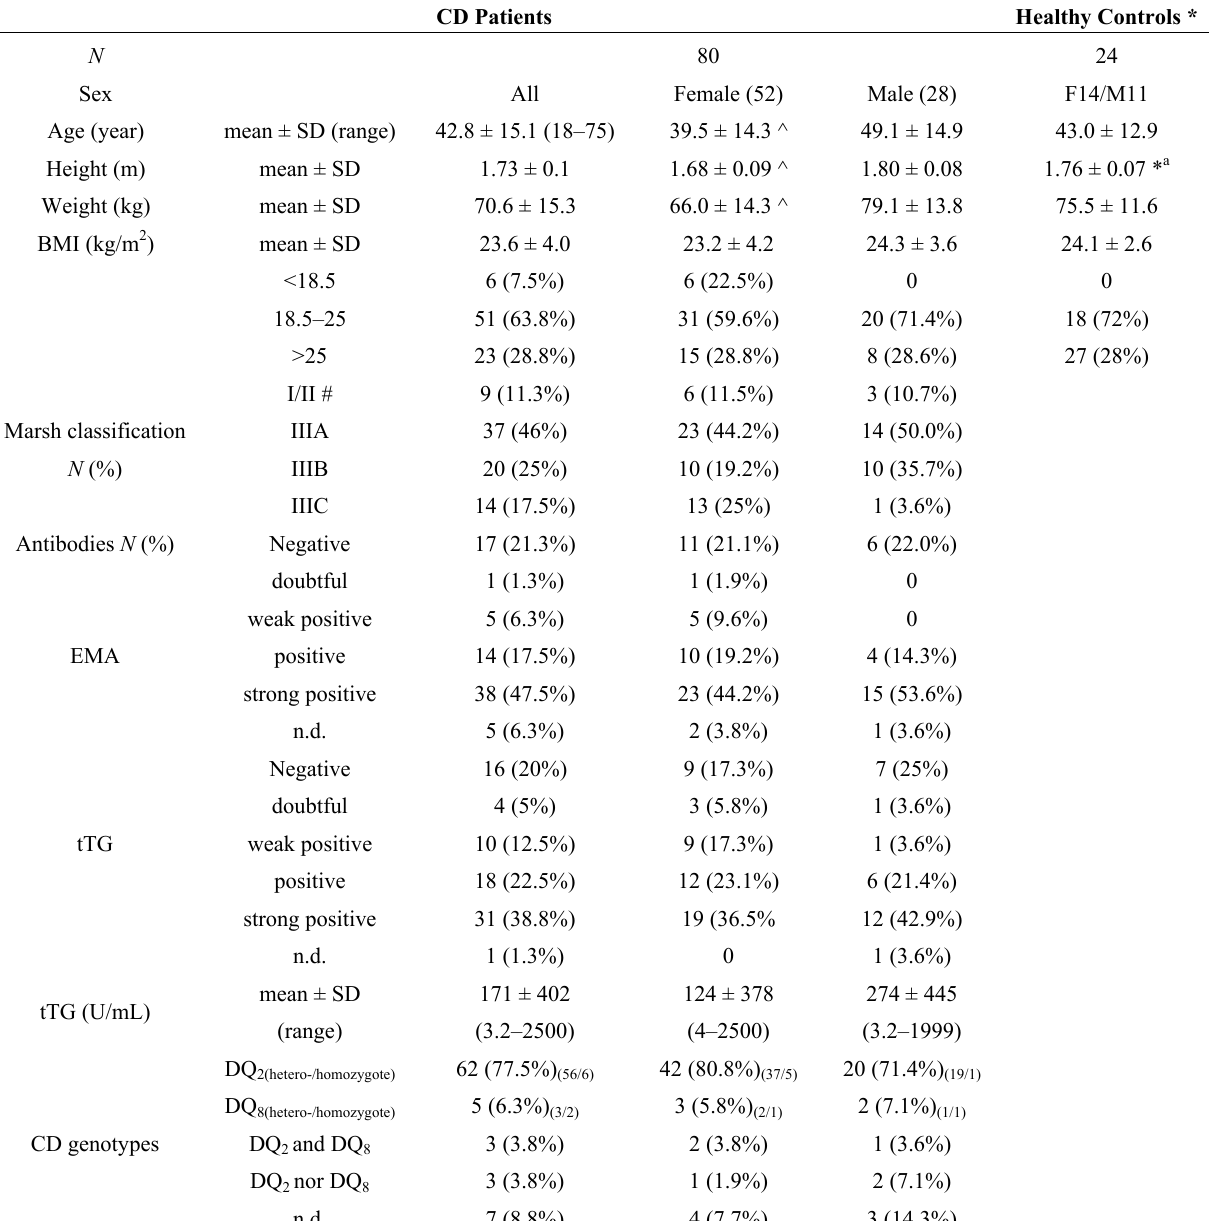
Table 2. Patient characteristics of untreated adult CD-patients by gender and compared to healthy